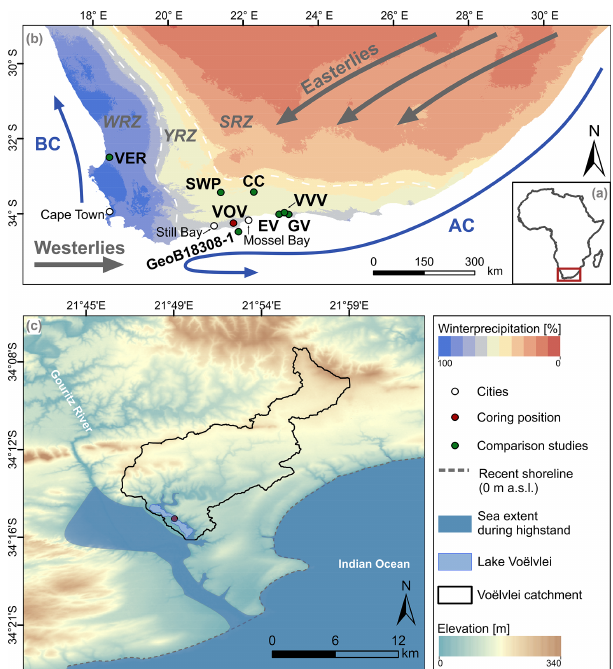
Figure 1. (a) Simplified map of Africa. The red box highlights the studied area. (b) Location of Lake Voëlvlei (VOV) and studies men- tioned in the text (Cango Cave: CC, Talma and Vogel, 1992; Eiland- vlei: EV, Quick et al., 2018; Wündsch et al., 2018; Groenvlei: GV, Wündsch et al., 2016a; Seweweekspoort: SWP, Chase et al., 2017; Verlorenvlei: VER, Kirsten et al., 2020; and Vankervelsvlei: VVV, Strobel et al., 2019). Additionally, the circumpolar westerlies, the tropical easterlies, the Agulhas Current (AC) and the Benguela Cur- rent (BC) are depicted. (c) Voëlvlei, its catchment, the coring posi- tion as well as a paleo-sea level highstand ( + 5m) and the recent shoreline (data sources – rainfall seasonality: WorldClim 2 dataset, Fick and Hijmans, 2017; circulation systems after Chase and Mead- ows, 2007; DEM: SRTM 1arcsec; ∼ 30m, Jarvis et al.,